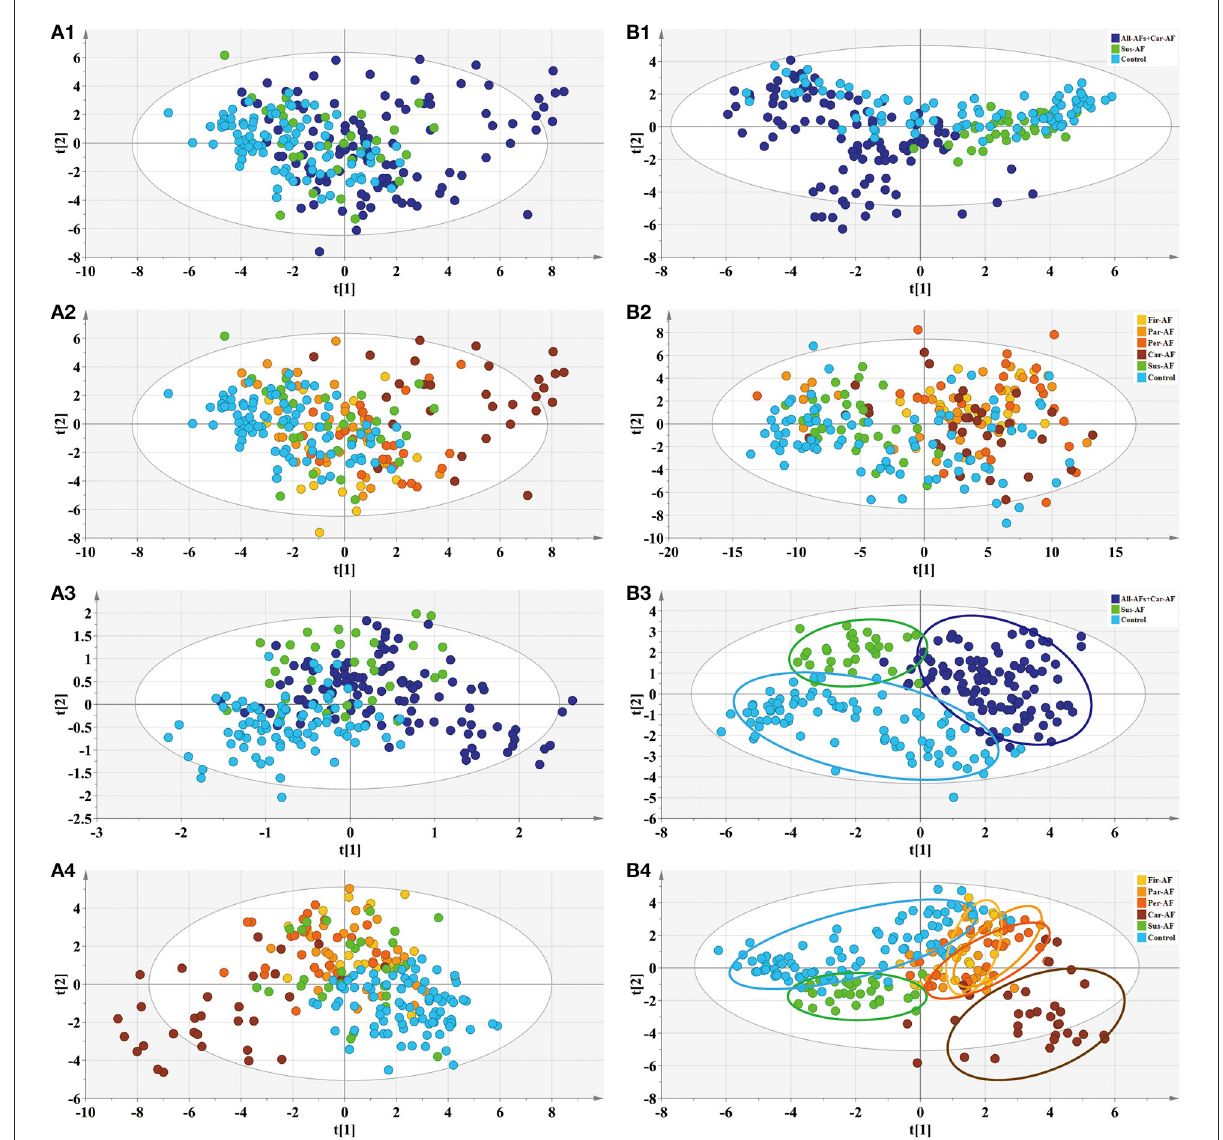
FIGURE2 Multivariate statistical analysis differentiates the groups of Control and Experimental groups based on clinical information (A) and metabolomic data (B) , respectively. (1) PCA modeling displays the original similarity of the three groups. (2) PCA modeling displays the original similarity of the six groups. (A1,A2) R2X (cum) = 0.499, Q2 (cum) = 0.204; R2X (cum) = 0.499, Q2 (cum) = 0.204. (B1,B2) R2X (cum) = 0.504, Q2X (cum) = 0.324; R2X (cum) = 0.508, Q2X (cum) = 0.369. (3) PLS-DA modeling with the three groups. (A3) R2X (cum) = 0.364, R2Y (cum) = 0.463, Q2X (cum) = 0.288. Permutation tests with the intercepts of R2 < 0.125, Q2 < − 0.338. (B3) R2X (cum) = 0.337, R2Y (cum) = 0.687, Q2X (cum) = 0.59. Permutation tests with the intercepts of R2 < 0.252, Q2 < − 0.312. (4) PLS-DA modeling with the six groups. (A4) R2X (cum) = 0.326, R2Y (cum) = 0.342, Q2X (cum) = 0.26. Permutation tests with the intercepts of R2 < 0.079, Q2 < − 0.134. (B4) R2X (cum) = 0.383, R2Y (cum) = 0.43, Q2X (cum) = 0.329. Permutation tests with the intercepts of R2 < 0.125, Q2 < −